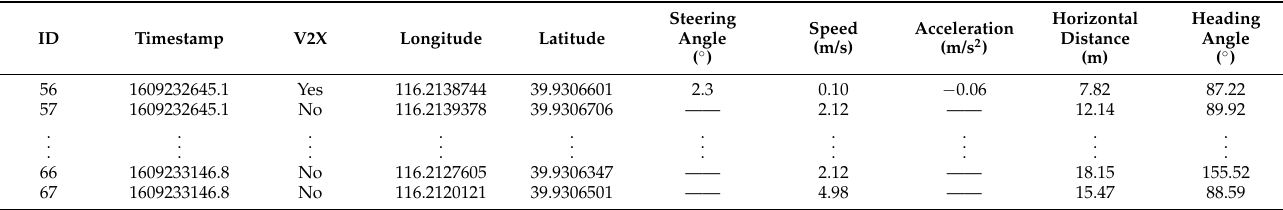
Table 4. Data states of vehicles at the intersection.